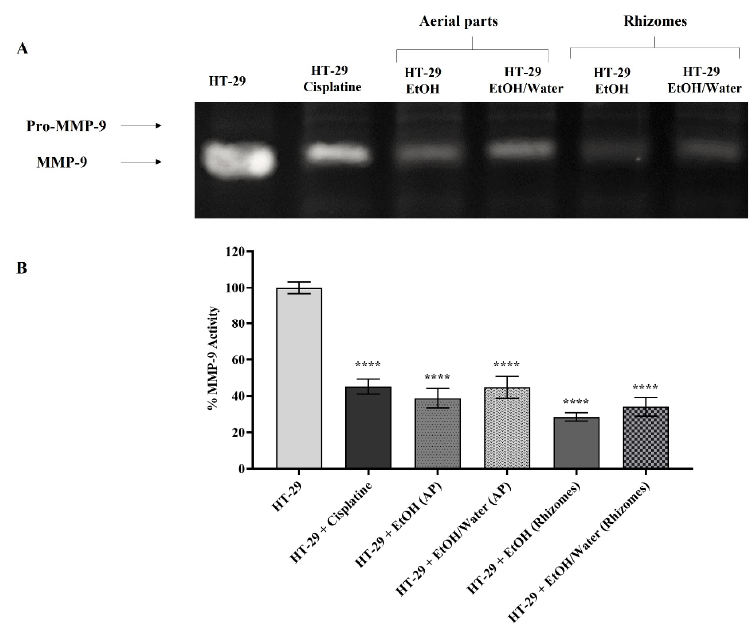
Figure 7. Detection of MMP-9 enzyme activity by gelatin zymography in HT-29 cell line treated with different Primula auriculata extracts and positive control cisplatin. Lytic white bands on the dark background of the gel stained with Coomassie brilliant blue were captured by ChemiDoc (in ( A )). For the detection of MMP-9 enzyme activity, untreated HT-29 cells were selected as the control, and the band intensity was measured with Image J. In the statistical analysis, p ≤ 0.0001 is presented with **** (in ( B )).